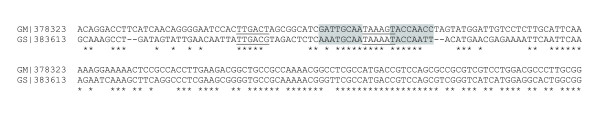
Pairwise sequence alignment of upstream regions of the perR-rbr-roo operons from Geobacter species. Conserved palindromic signal, that is the candidate PerR-box, is highlighted in gray. Predicted SD-boxes and start codons of the perR genes are in bold. Predicted -10 and -35 promoter boxes are underlined. *Conserved position of alignment. See Figure 1 legend for abbreviations.